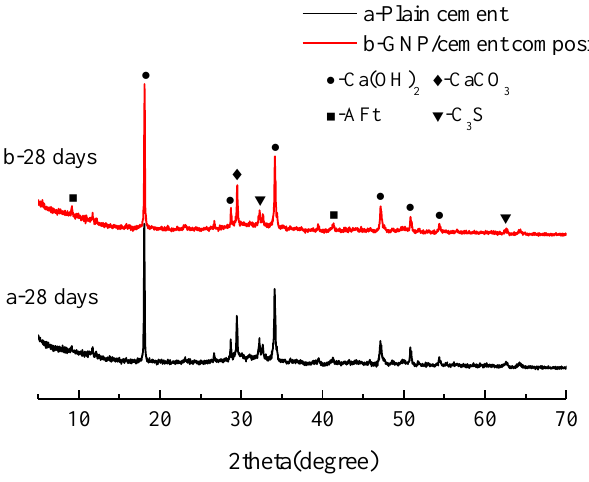
Figure 6. XRD patterns of ( a ) plain cement paste and ( b ) GNP-cement composite at the age of 28 days.